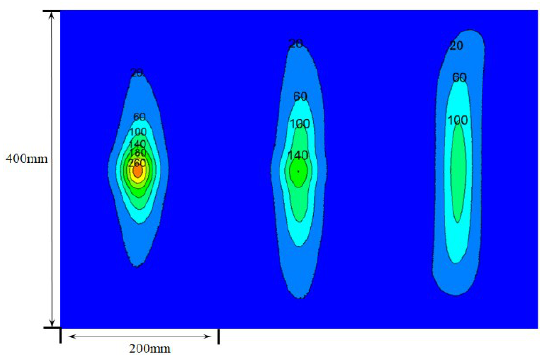
Figure 15. Pressure contour of the target surface at different shaping air pressures, when Δ = 7.3 (Pa) (the pressures from left to right were 30,000, 50,000, and 70,000 Pa).